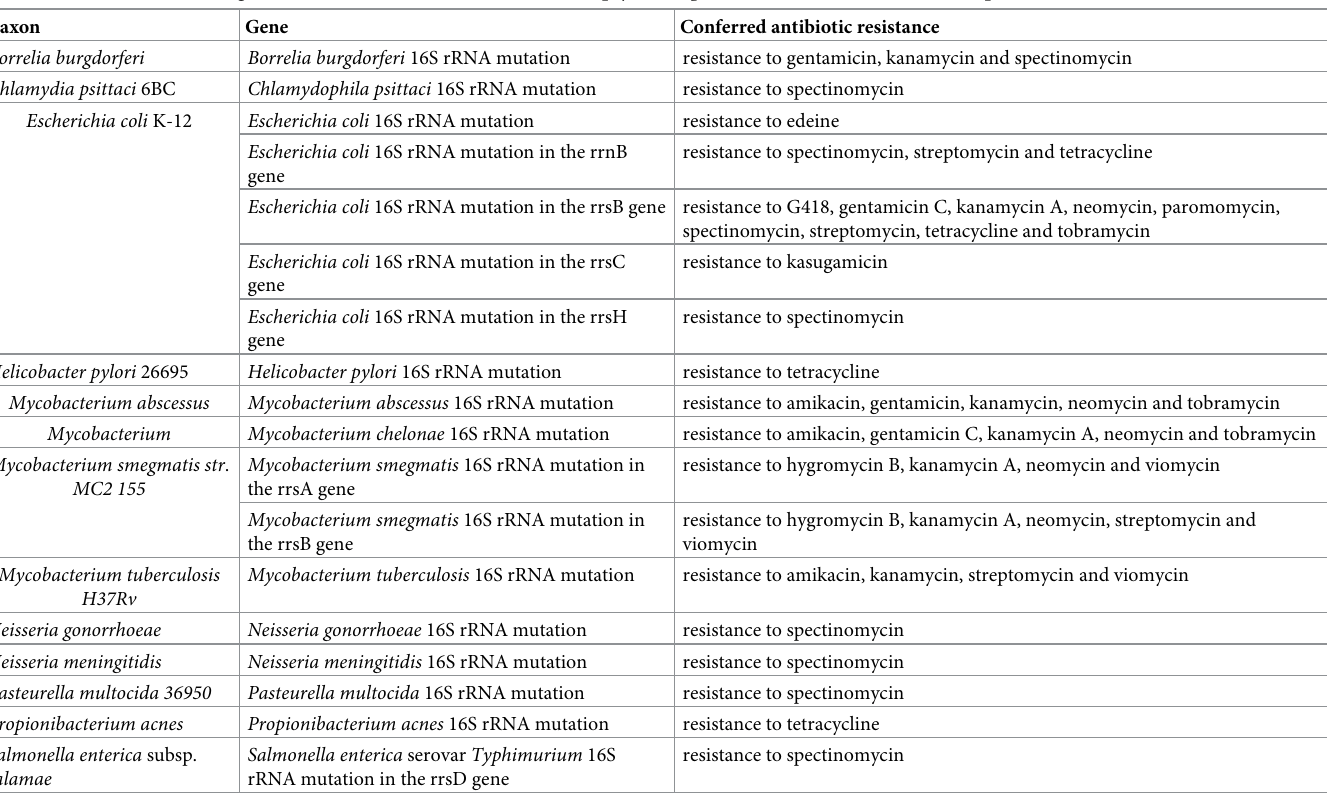
Table 2. Antibiotic resistance genes found in the microbiome of the citrus psyllid Diaphorina citri , as obtained from comprehensive antibiotic resistance database.